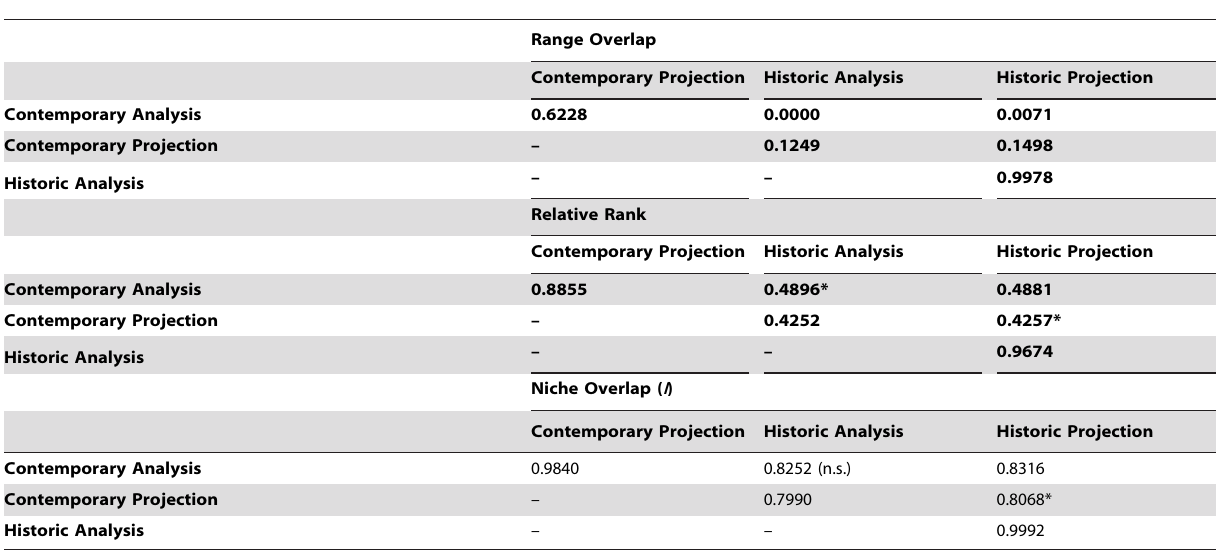
Table 2. Niche comparison metrics as calculated in ENMtools.